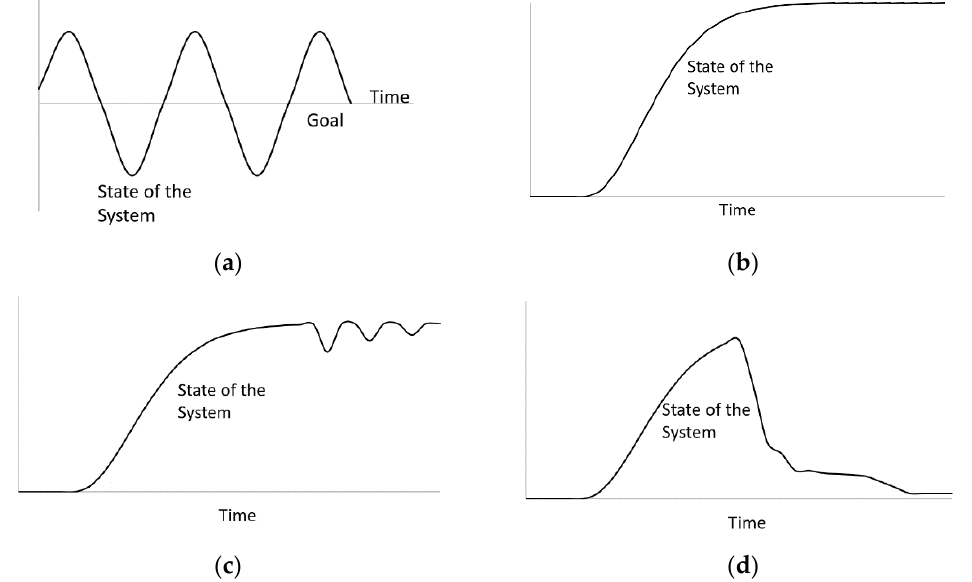
Figure 3. ( a ) Oscillation; ( b ) S-shaped growth; ( c ) S-shaped growth with overshoot, and ( d ) Overshoot and collapse.